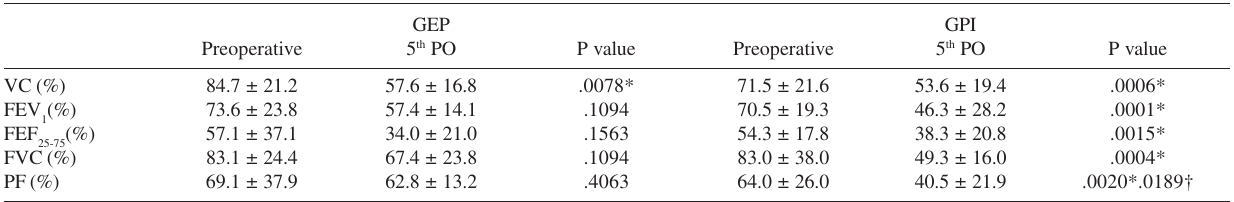
Table 2 - Spirometric variables in the preoperative and postoperative treatment (5 th PO) with statistical results for intra- and inter-groups (mean ± SD) GEP GPI